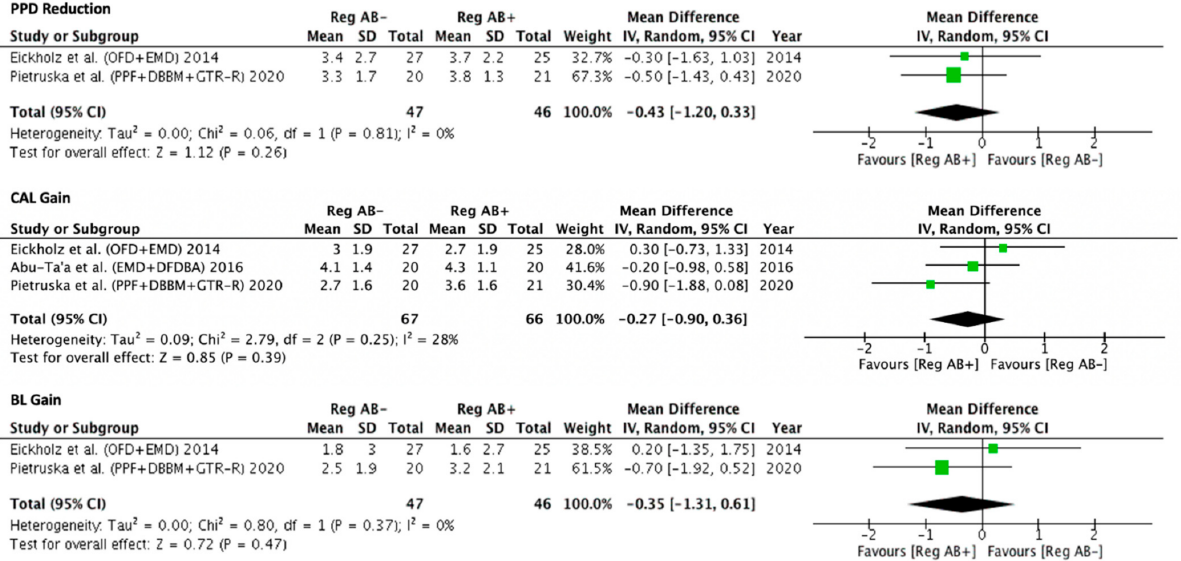
Figure 1. Forest plots of pair-wise meta-analyses for PPD reduction, CAL gain and bone gain for studies directly comparing regenerative techniques in intrabony defects with or without adjunctive